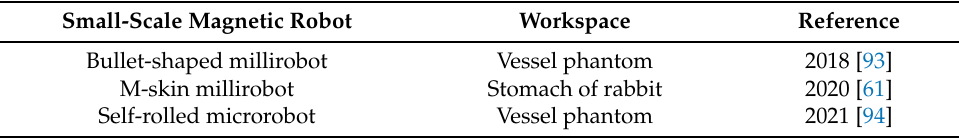
Table 3. Exemplar studies of small-scale magnetic robots with X-ray imaging modality. Small-Scale Magnetic